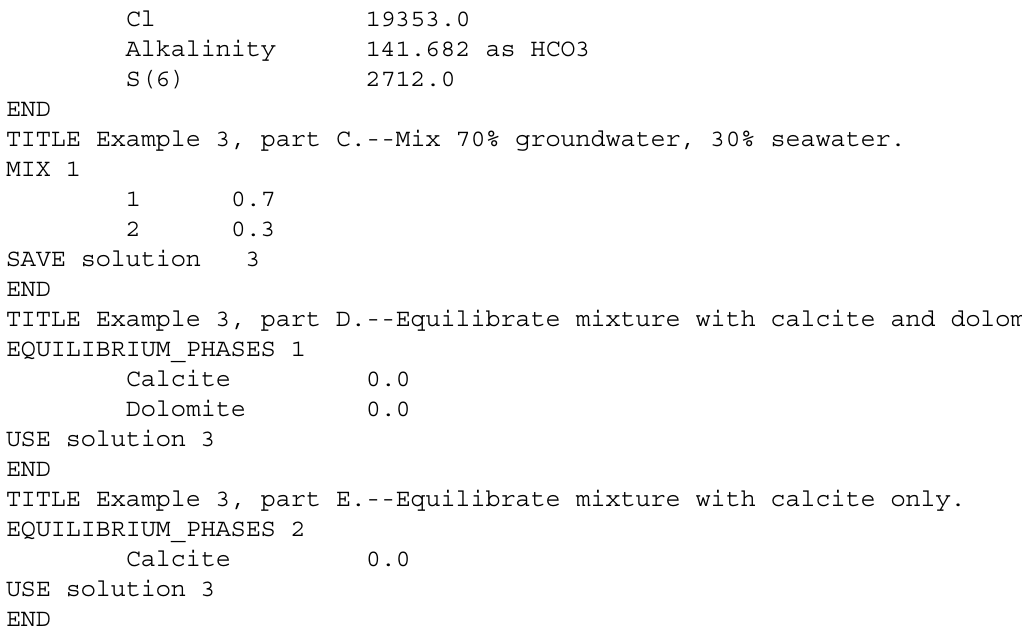
Table 15. Input file for example